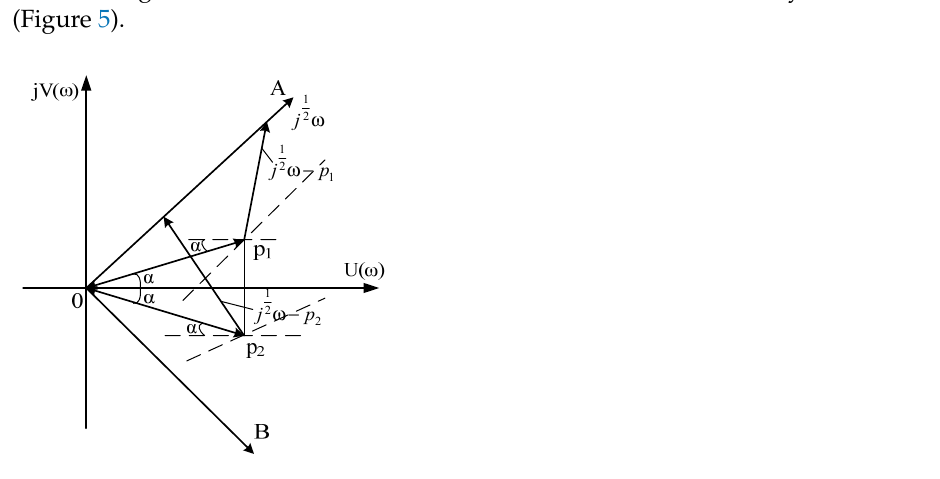
Figure 5. Vector displacement for the first two complex-conjugate roots for the case when 𝜔 𝜖 (0, ∞) .